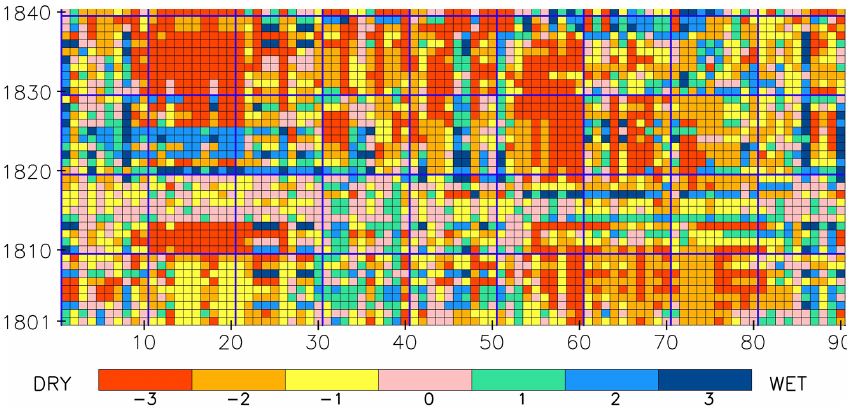
Figure 5. Seven-point “wetness” index series for 1801–1840 for the 90 homogenous rainfall regions of Africa indicated across the x axis. This series is reconstructed using documentary and instrumental data, with data gaps infilled using substitution and statistical inference (see Sect. 8.3 and Nicholson et al., 2012a). From left to right, the regions approximately extend by latitude from the northern (region 1 – northern Algeria/Tunisia) to southern (region 84 – Western Cape, South Africa) extremes of the continent. Anomalies in the numbering sequence are regions 85, 86, 90 (all equatorial Africa), 87 (eastern Africa), and 88 and 89 (Horn of Africa).